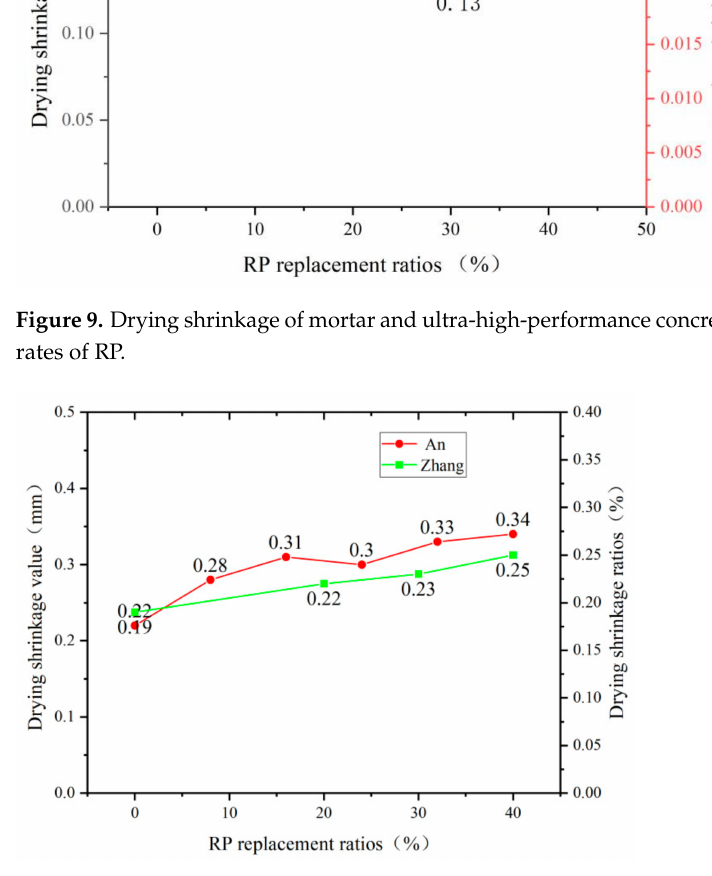
Figure 10. Drying shrinkage of foam concrete with different replacement rates of RP